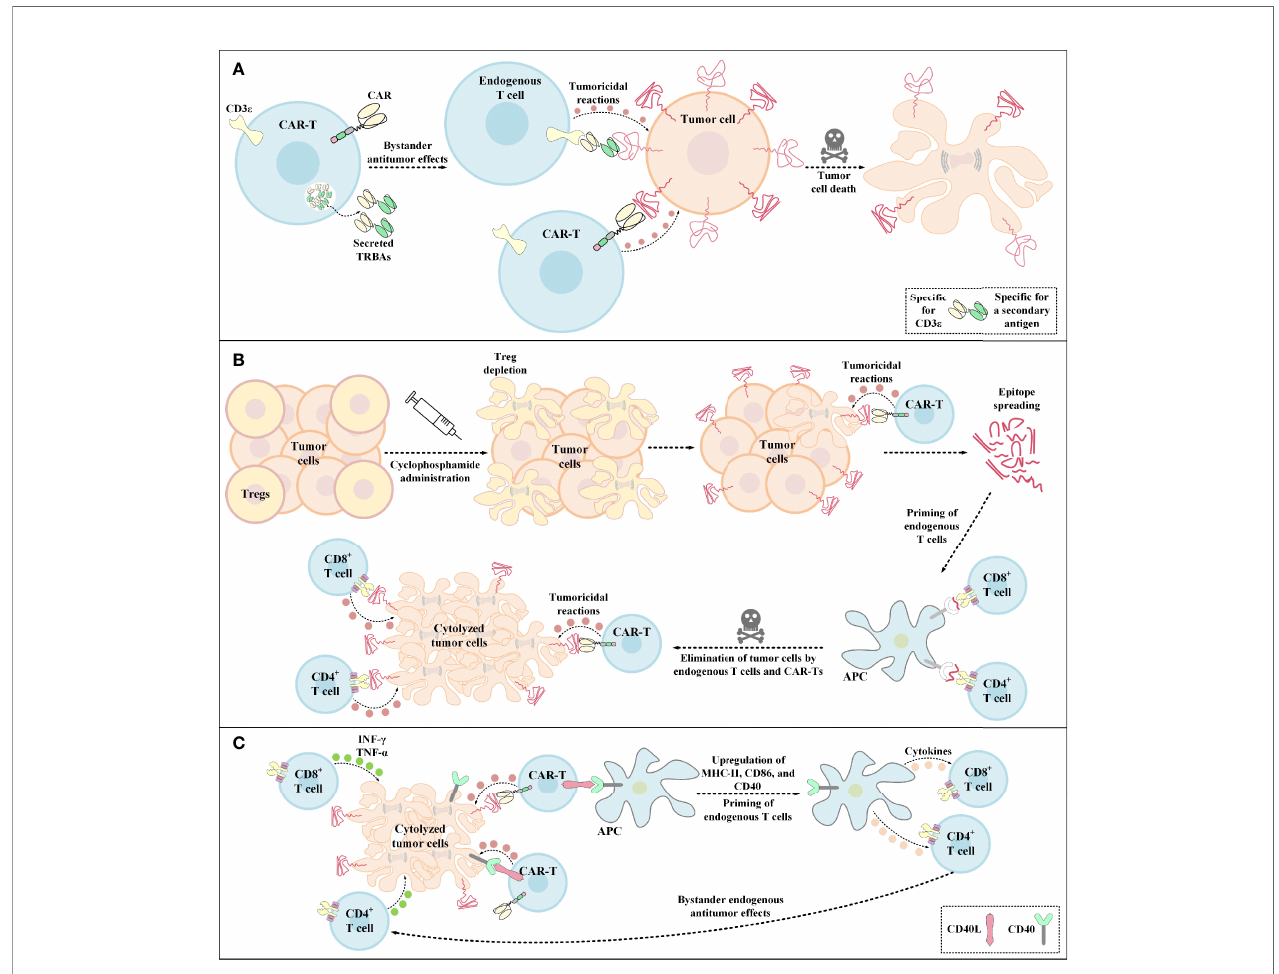
FIGURE 4 | Bystander antitumor effect induction by TRBA-secreting CAR-Ts, cyclophosphamide administration, and CD40L-expressing CAR-Ts. (A) TRBA- secreting CAR-Ts. TRBAs are made of two scFvs fused via a linker peptide. One of these scFvs targets CD3 (present on the surface of endogenous T cells) and the other one targets a TAA or TSA of interest against which endogenous T-cell responses are intended to be redirected. TRBA-secreting CAR-Ts secrete these bispeci fi c T-cell-redirecting antibodies which results in endogenous T-cell-mediated antitumor reactions against malignant cells alongside CAR-T-mediated tumoricidal responses enabling a more effective tumor cell elimination. (B) Cyclophosphamide administration. Cyclophosphamide administration mediates Treg depletion and enables a more ef fi cient CAR-T engagement with its target antigen and the subsequent CAR-T-mediated tumoricidal reactions. Additionally, upon epitope spreading, APCs uptake the released peptide antigens and present them to CD4 + T cells and CD8 + T cells. This mechanism leads to the priming of endogenous T cells and the subsequent elimination of tumor cells through bystander antitumor effects mediated by these endogenous cells. (C) The mechanism of action of CD40L + CAR-Ts. CD40L + CAR-Ts can mediate tumor cell cytolysis through both their CAR and their CD40L interacting with the CAR target antigen and CD40 on the surface of tumor cells, respectively. Additionally, CD40L + CAR-Ts mediate DC licensing as indicated by the upregulated level of CD40, CD86, and MHC-II. These APCs in turn recruit other immune effector cells such as endogenous T cells. INF- g and TNF- a secretion by the recruited endogenous CD4 + T cells and CD8 + T cells also result in tumor cell cytolysis. APC, antigen-presenting cells; CAR, chimeric antigen receptor; CD40L, CD40 ligand; INF- g , interferon g ; MHC-II, major histocompatibility complex class II; TNF- a , tumor necrosis factor a ; TRBAs, T-cell-redirecting bispeci fi c antibodies; Treg, regulatory T